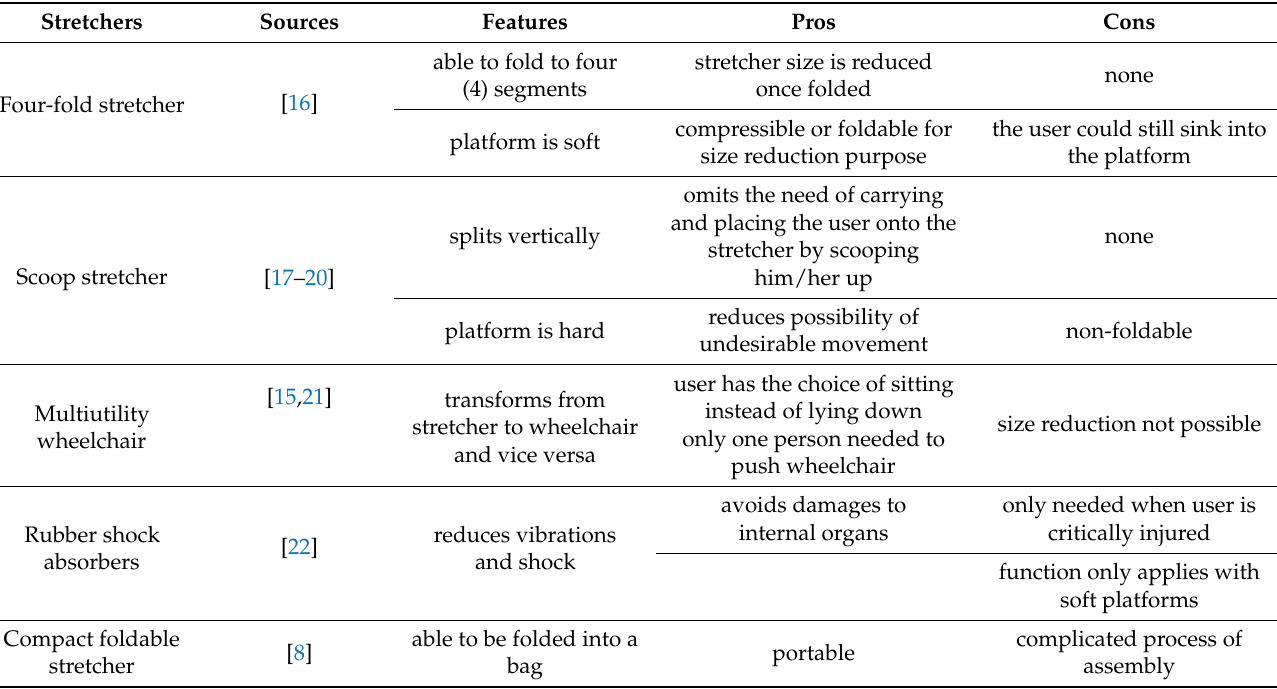
Table 1. Primary features of various stretchers